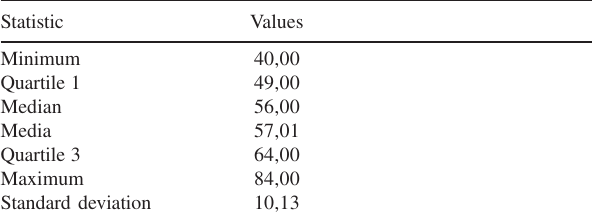
Table 4 - Distribution of patients by age group Statistic